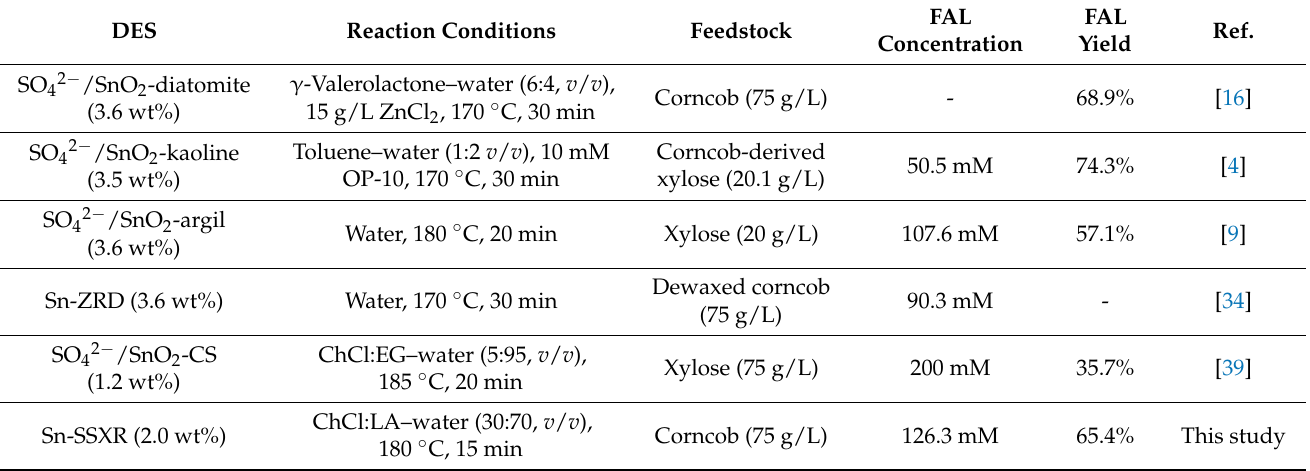
Table 1. Related works about synthesis of FAL from biomass or xylose by using tin-based solid